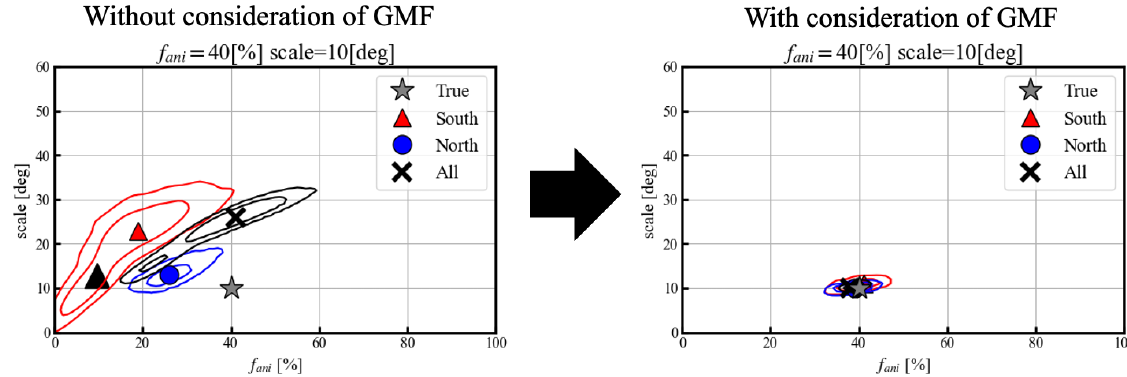
,θ true ) = (40% , 10 deg). The ani ,θ true ) are shown by the grey stars. The black, blue, and red ani ,θ Auger ) = (9 . 7% , 12 . 9deg) in [5] is shown ani